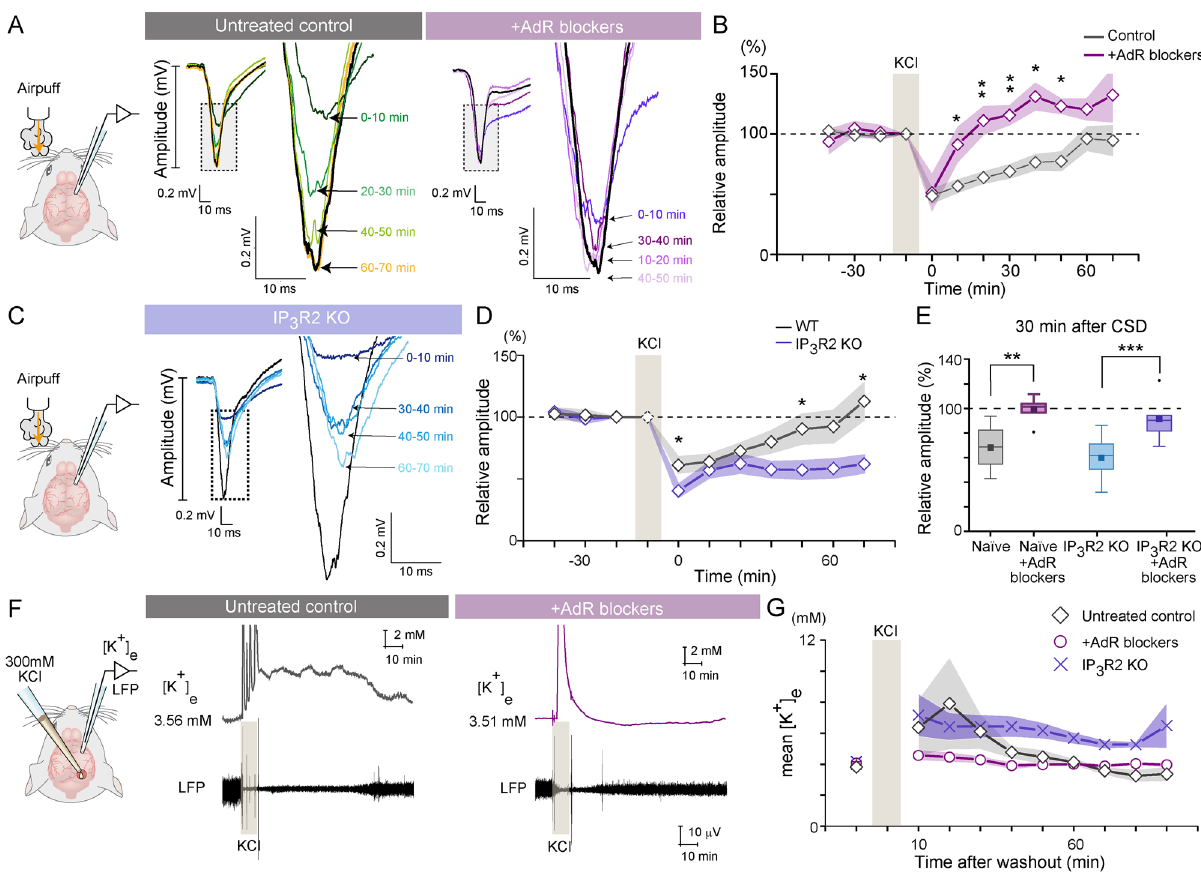
Figure 4. AdR antagonism enhances recovery of post-CSD neural activity and facilitates K + clearance. ( A ) Mean traces of whisker-evoked barrel cortex layer 2/3 LFP recorded before (black) and after CSD (colors). Insets: full-range LFP waveforms. Dotted rectangular areas are magnified on the right. A mouse pretreated with AdR blockers shows similar LFP responses before and 30–50 min after CSD (black, orange and purple lines, respectively). ( B ) Effect of AdR blocker pretreatment on the recovery of whisker-evoked LFP after KCl-induced CSD. AdR blocker pretreatment (N = 6) vs. untreated control group (N = 7). ( C ) Mean whisker-evoked LFP traces measured in IP 3 R2 KO mice. ( D ) Comparison of the recovery of whisker response after KCl-induced CSD between WT mice (N = 7) and IP 3 R2 KO mice (N = 6). ( E ) Amplitudes of whisker-evoked LFP 30 min after KCl removal normalized to amplitude in the pre-KCl period. WT (N = 7), AdR blocker-pretreated WT (N = 6), IP 3 R2 KO (N = 6), and AdR blocker-pretreated IP 3 R2 KO mice (N = 7). ( F ) In vivo [K + ] e measurement and LFP recording were made simultaneously in the somatosensory cortex 2 mm away from the KCl application site. The example traces show that [K + ] e is elevated upon KCl application and gradually recovers after KCl removal. Spontaneous LFP activity is low while [K + ] e is high (left). AdR blocker pretreatment does not have profound effects on basal [K + ] e or LFP, but facilitates K + clearance and LFP recovery after KCl removal (right). ( G ) Effect of AdR blocker pretreatment on K + clearance. Median values for 10-min intervals are plotted. Untreated control (diamond, N = 8), and AdR blocker-treated mice (circle, N = 6), IP 3 R2 KO (cross, N = 6), Shades on line plots represent the area within mean ± SEM. *p < 0.05, **p <